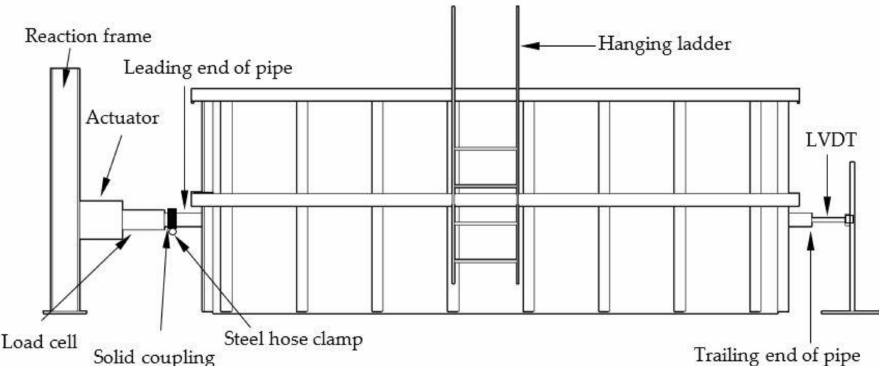
Figure 1. Test cell